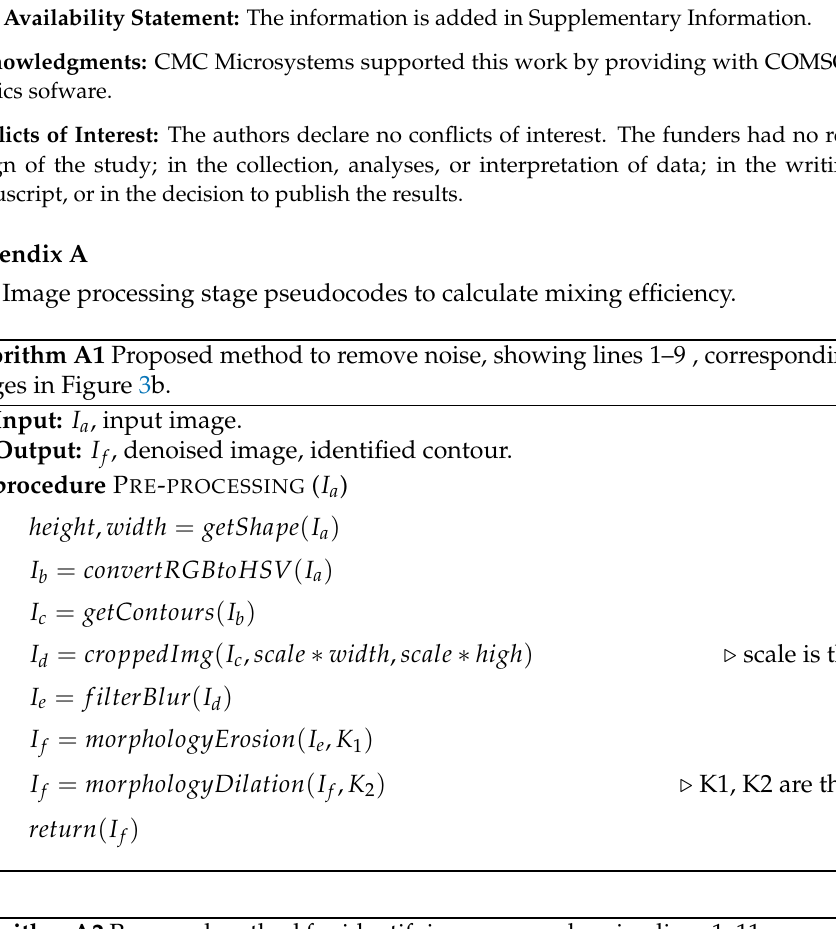
Algorithm A2 Proposed method for identifying corners, showing lines 1–11, corresponding to the images in Figure